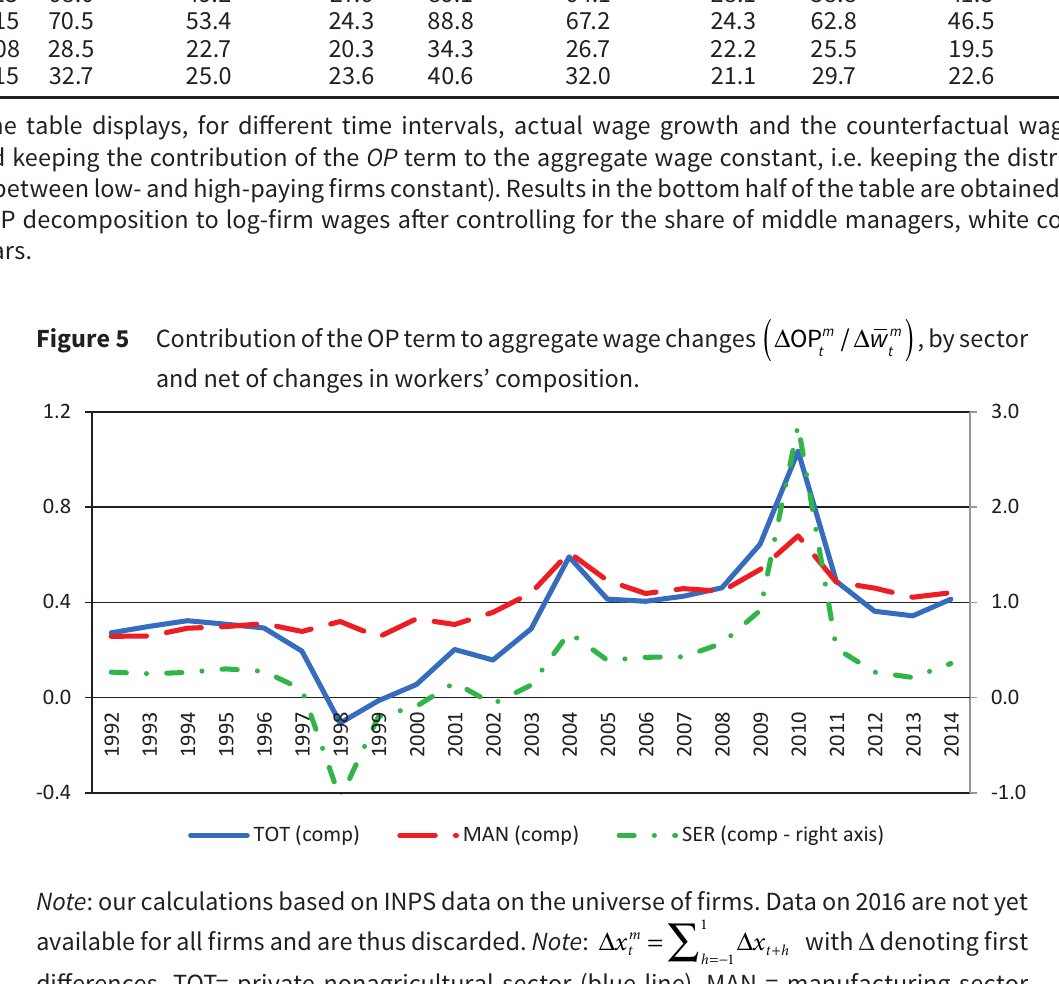
position by using the residual of a regression of wages at the firm level on the occupational composition of workers in each firm, as a measure of net wages of workers’